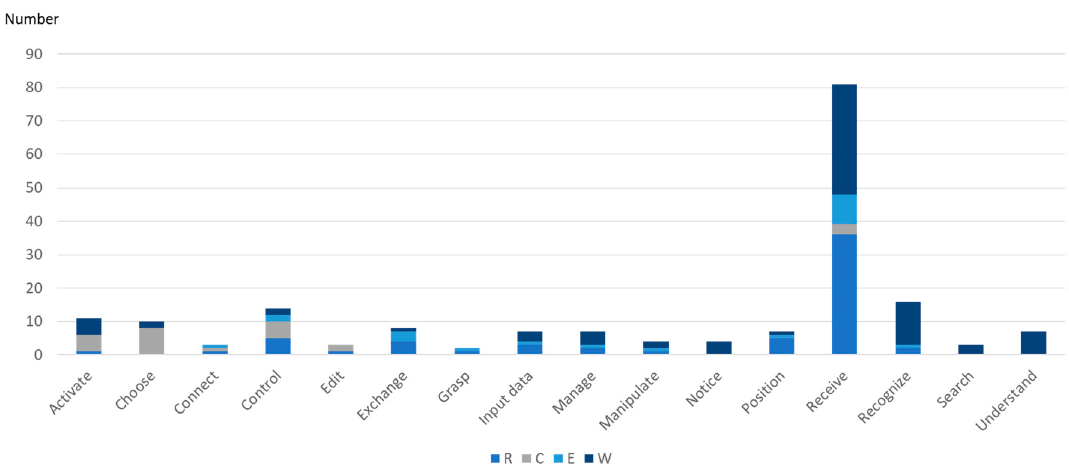
Figure 2. Depiction of the numbers of tasks by provisions and guidelines.